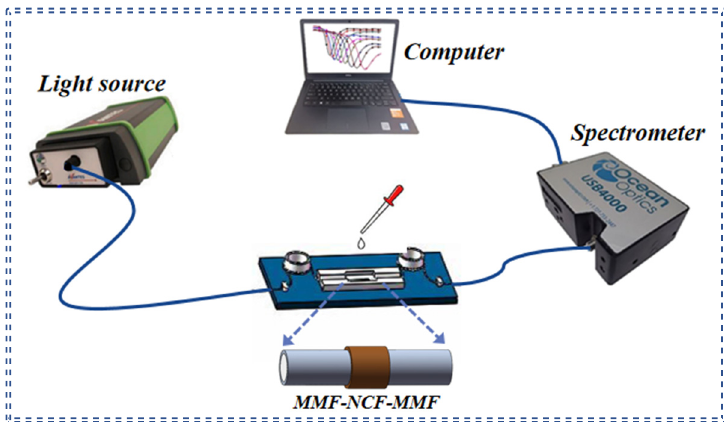
Figure 6. Schematic diagram of the experimental setup.